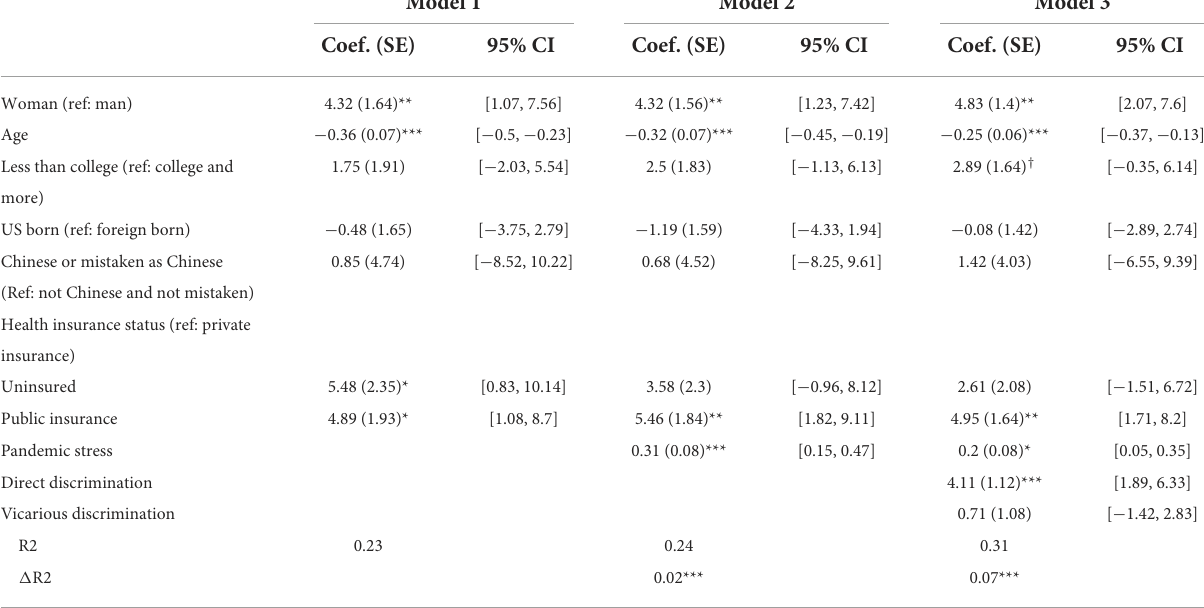
TABLE 6 Hierarchical regressions for psychological distress: Southeast